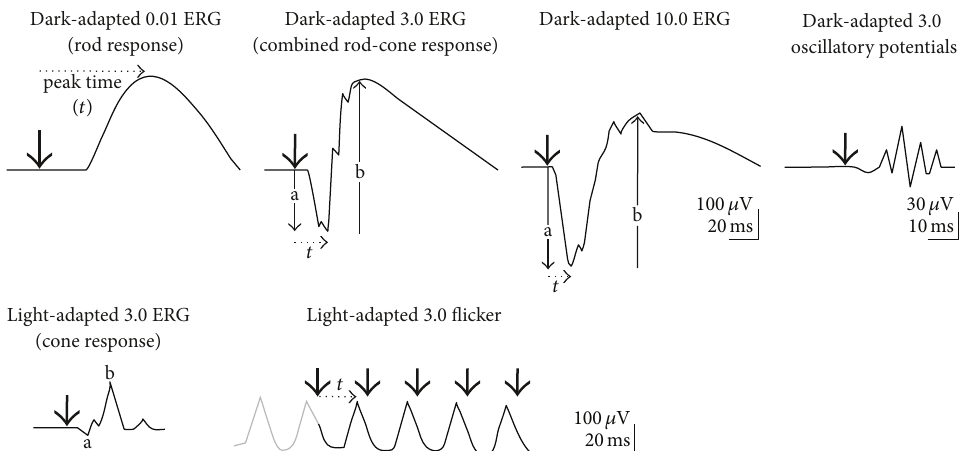
Figure 1: Diagram of the six basic ERGs defined by the ISCEV Standard. These waveforms are exemplary only and are not intended to indicate minimum, maximum, or typical values. Bold arrowheads indicate the stimulus flash; solid arrows illustrate a-wave and b-wave amplitudes; dotted arrows exemplify how to measure time to peak ( 𝑡 , implicit time or peak time) ( to be reprinted with permission from McCulloch et al. ISCEV Standard for full-field clinical electroretinography (2015 update) [17]. Documenta Ophthalmologica: Advances in Ophthalmology . 2015, 130(1):